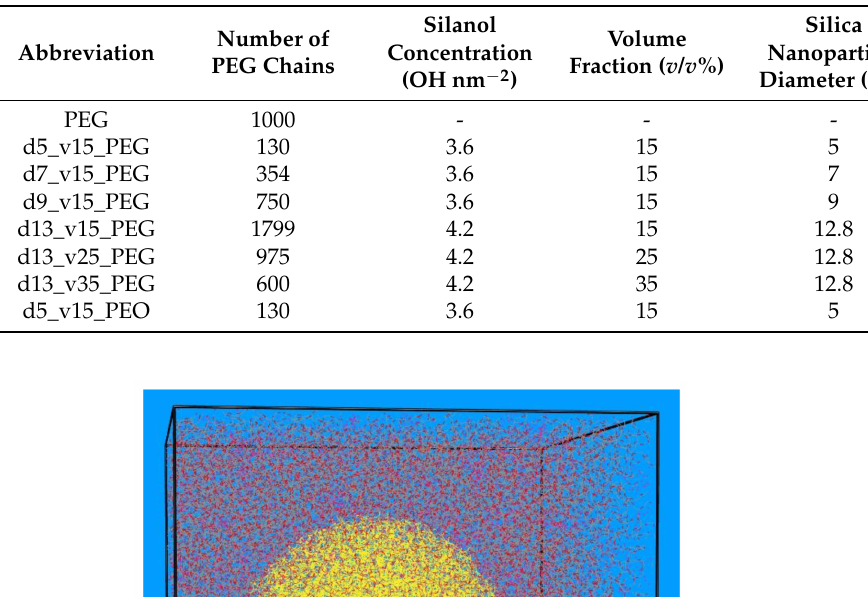
Table 1. Molecular characteristics of the simulated systems.